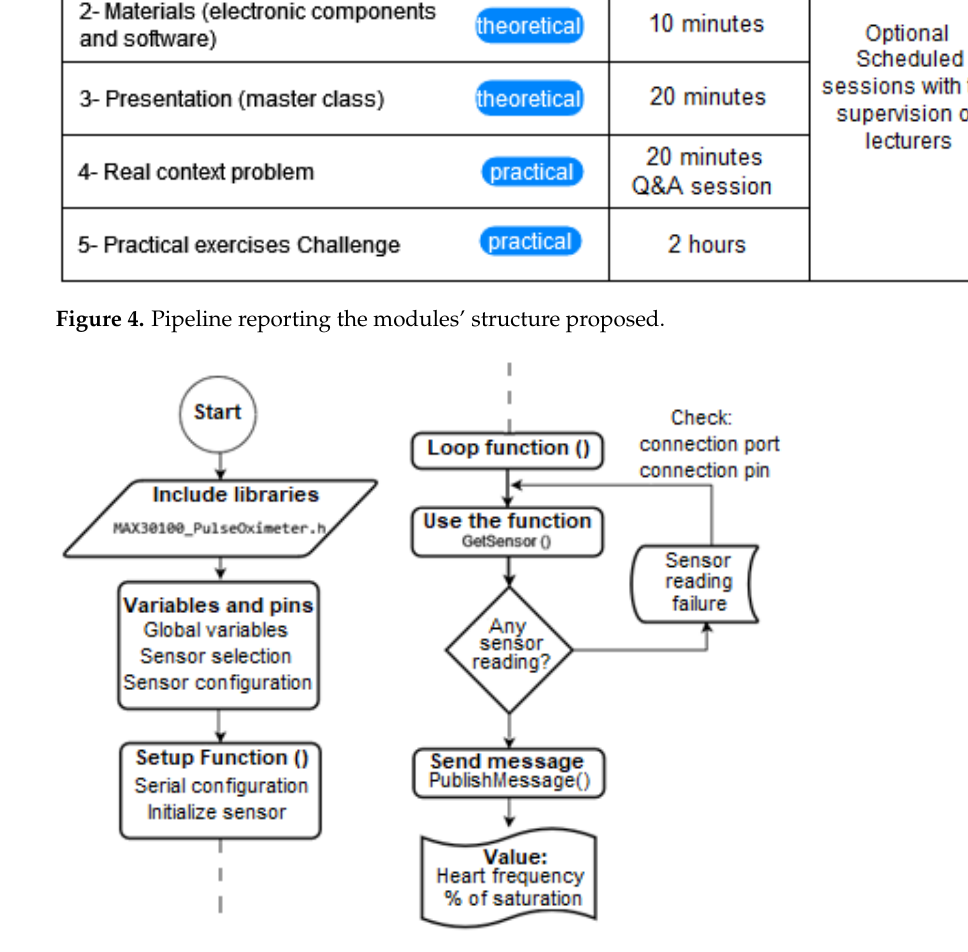
Figure 5. Pipeline for the assignment related to IoMT applications.